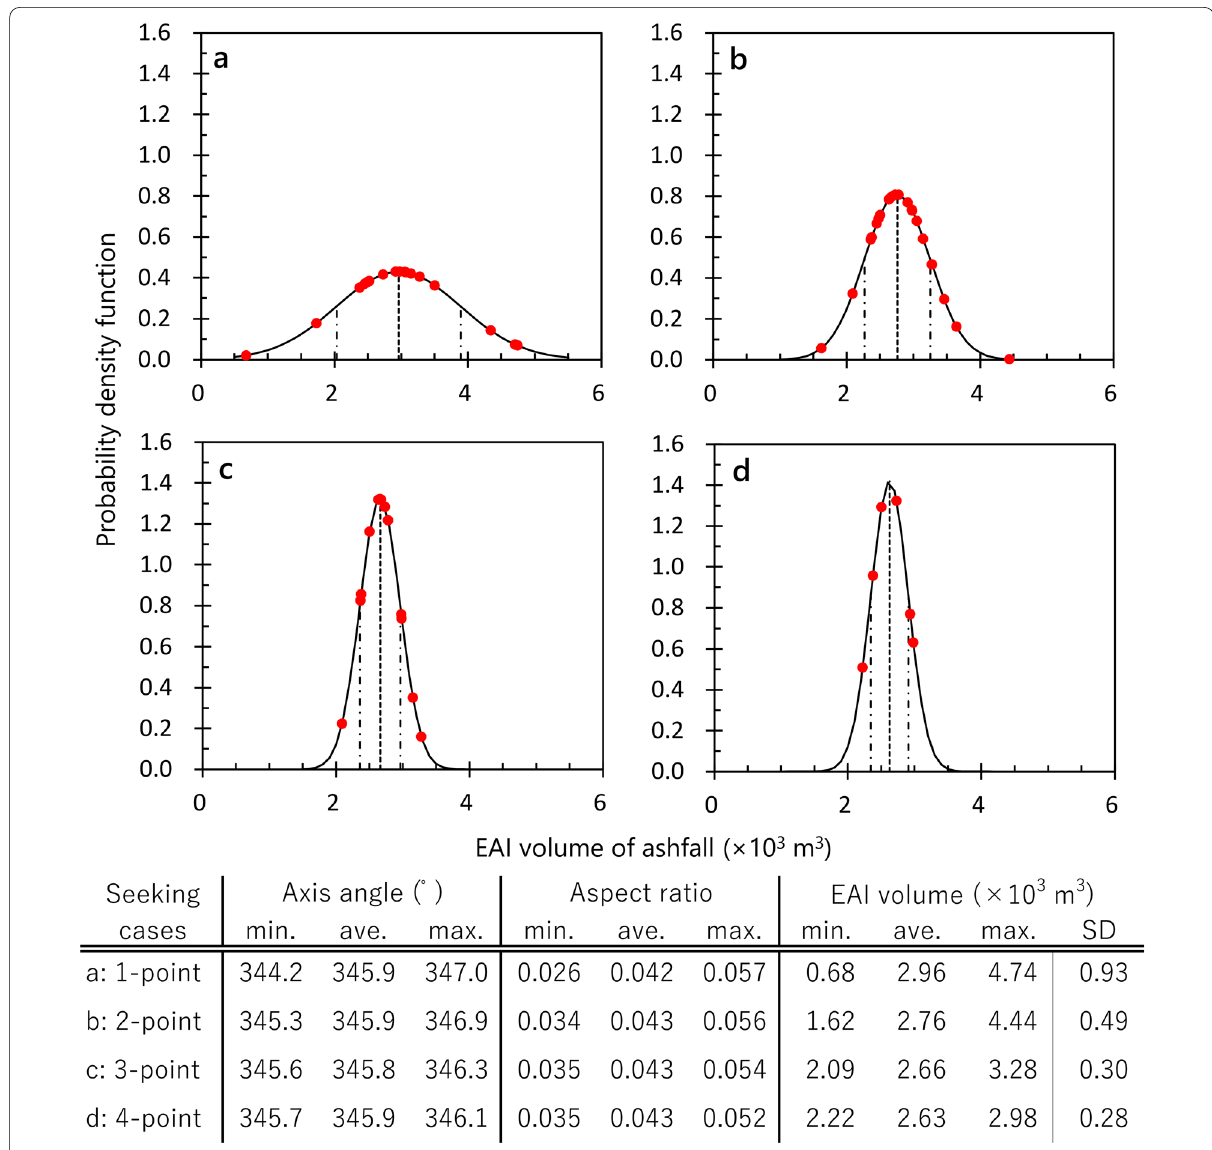
Fig. 5 Probability density function of the EAI volume with 1–4 seeking points. a Result of the one-point seeking cases. b Result of the two-point seeking cases. c Results of the three-point seeking cases. d Results of the four-point seeking cases. The table at the bottom denotes the EAI analysis results with different point-seeking numbers for the small eruption of Shinmoedake volcano on June 27,